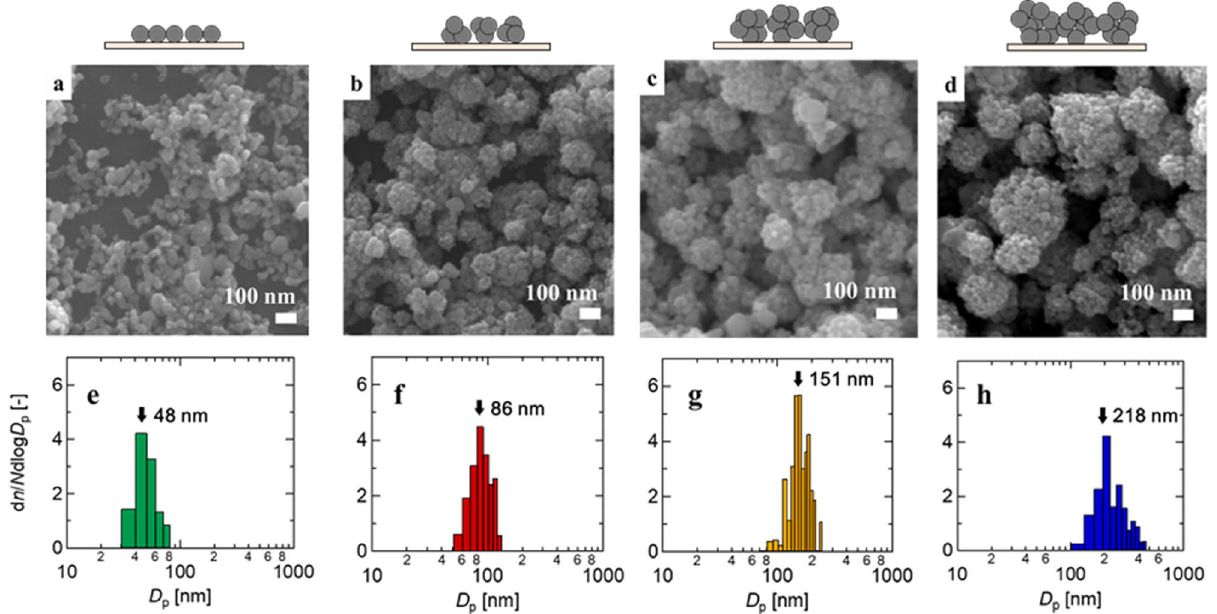
Figure 3. SEM images and size distributions of the deposited AgNPs. ( a, e ) 48 nm, ( b, f ) 86 nm, ( c, g ) 151 nm, and ( d, h ) 218